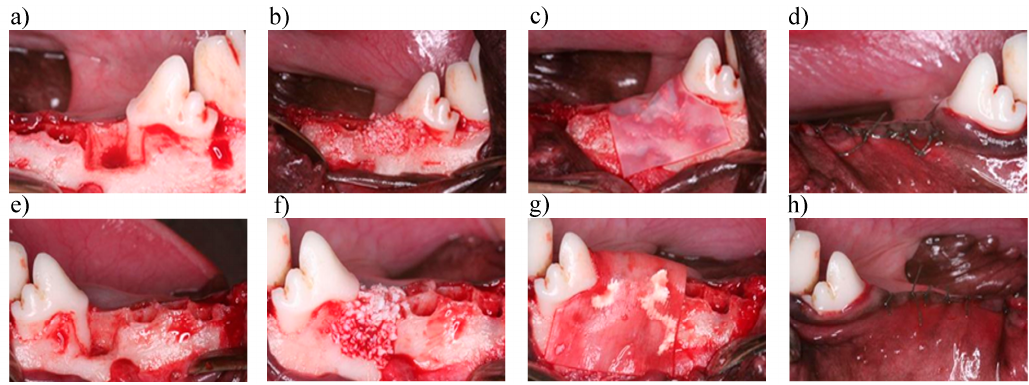
Figure 1. Surgical procedure for the treatment of bone defects in both groups. ( a ) Left bone box-shaped 5 mm × 5 mm defect prepared at the mesial side of the fourth premolar; ( b ) Xenograft placement within the defect; ( c ) The graft covered with the test collagen membrane; ( d ) primary closure was achieved. Steps in the surgical site; ( e ) Right bone box-shaped 5 mm × 5 mm defect prepared at the mesial side of the fourth premolar; ( f ) Xenograft placement within the defect; ( g ) The graft covered with the control membrane; ( h ) primary closure was achieved.